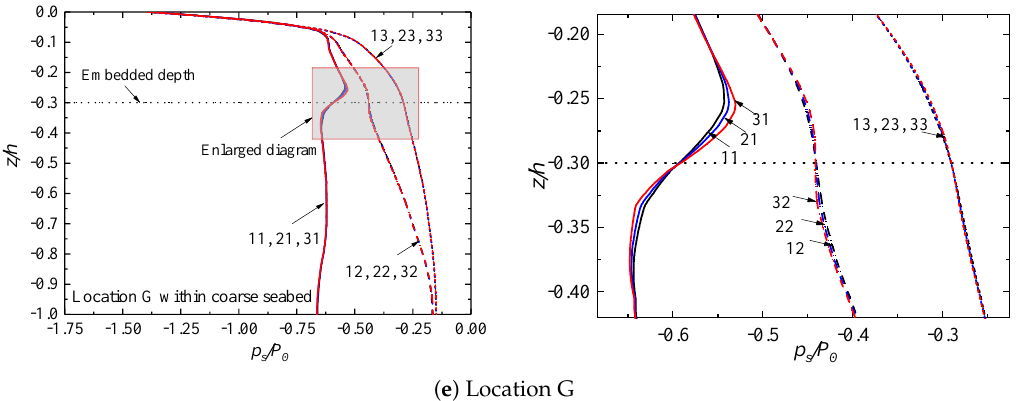
Figure 16. Vertical distributions of pore pressure at characteristic locations within a coarse seabed at t = 83.5 s.